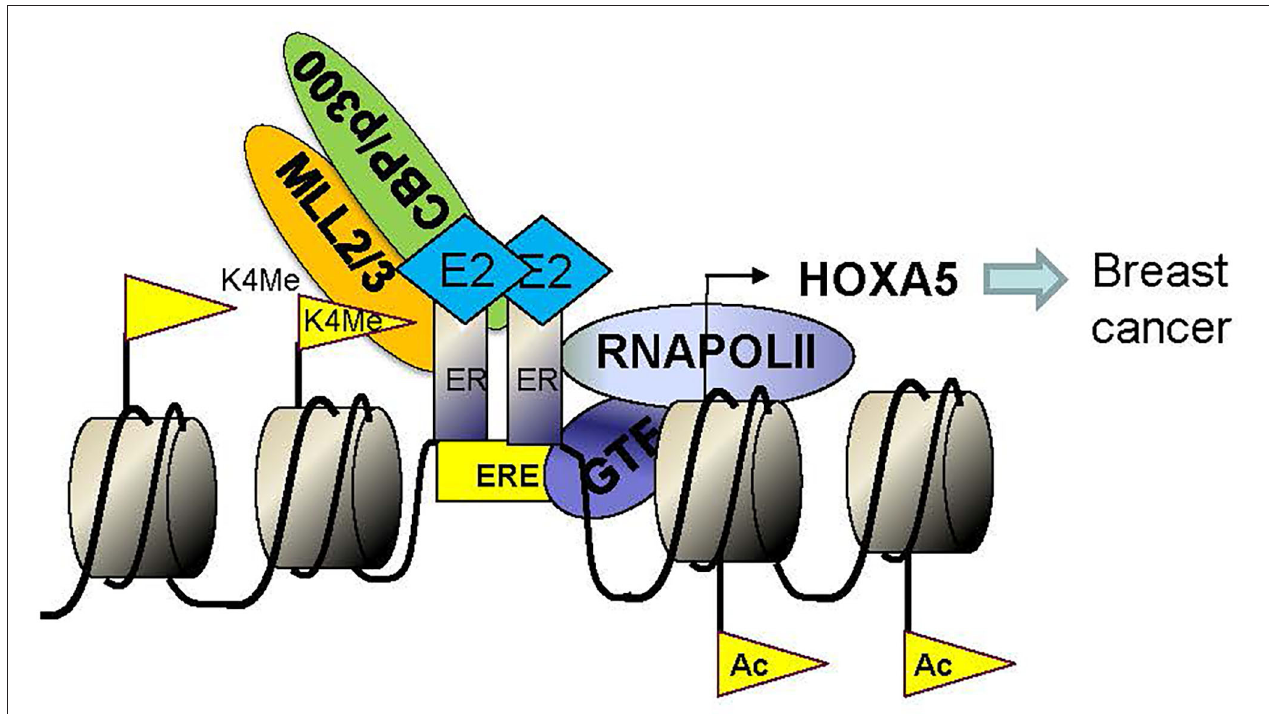
FIGURE 8 | Model showing the mechanism of E2-mediated activation of HOXA5. Binding of E2 induces conformational change in ERs and induces dimerization and activation of ERs. Activated ER dimers enter the nucleus, bind to the HOXA5 promoter (EREs). ER co-regulators (CBP, p300, MLL2, MLL3, and others) also bind to the HOXA5 promoter, modify chromatins (H3K4-trimethylation via MLL2 and MLL3 and histone acetylation via CBP/p300), aid in recruitment of RNA polymerase II (RNAP II) and general transcription factors (GTFs) to the promoter and ultimately lead to transcription activation of